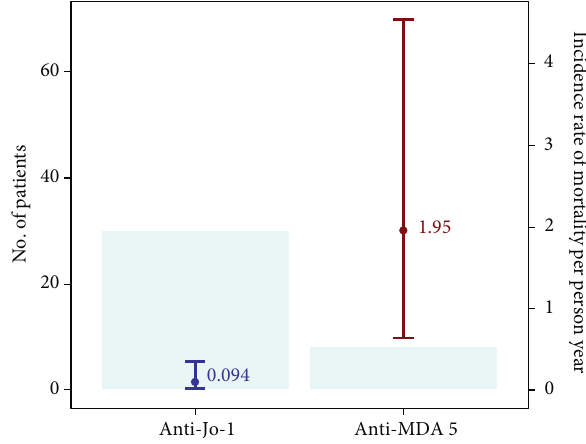
Figure 2: One-year mortality rate of anti-Jo-1 and anti-MDA-5